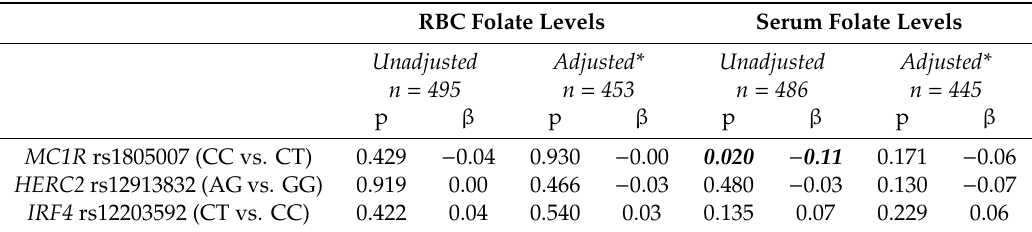
Table6. Associationbetweenskinpigmentationvariantsandfolatelevels, withandwithoutadjustments for folate